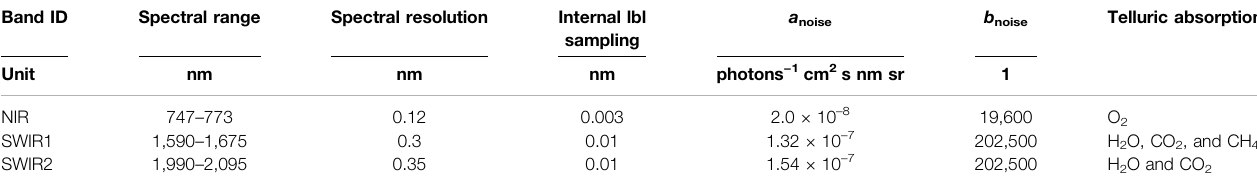
TABLE 2 | Characteristics of the CO2I spectrometer with a spectral sampling ratio of 3.